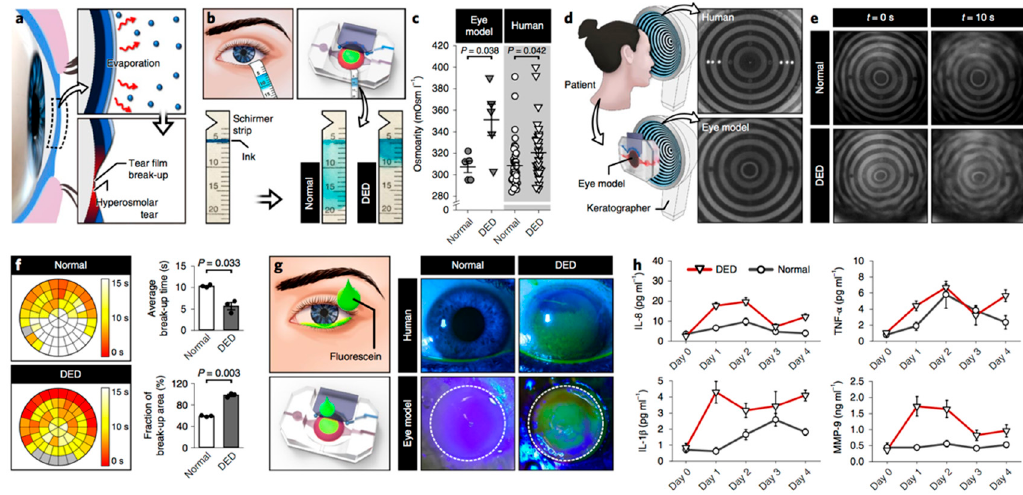
Figure 4. An engineered model of evaporative dry eye disease. ( a ) Evaporation causes the break-up of the tear film and increases tear osmolarity that together leads to a loss of homeostasis. ( b ) Absorption of tears into the Schirmer strips in the healthy and dry eye models. Tear absorption is visualized by the smearing of the blue ink within the strips. ( c ) Tear osmolarity in the DED (closed triangle) and the normal (closed circle) models. Human clinical data of osmolarity are from normal subjects (open circle) and DED subjects (open triangle). ( d ) Keratographs showing concentric rings projected on the human ocular surface (top) and the engineered ocular surface (bottom). ( e ) Representative images of projected ring patterns on the engineered ocular surface of the healthy (top row) and the DED (bottom row) groups captured at t = 0 s (left column) and t = 10 s (right column). ( f ) Spatial mapping of tear film break-up time in the normal (top) and the DED (bottom) models. Different colors in the representative circular heat maps indicate different tear break-up times. ( g ) Fluorescein staining of the eye model and human subjects. ( h ) Concentrations of inflammatory mediators (IL-8, TNF- α , IL-1 β , and MMP-9) in the normal (circle) and the DED (triangle) groups plotted against the duration of culture. Figure taken from Jeongyun Seo et al. with permission [109].